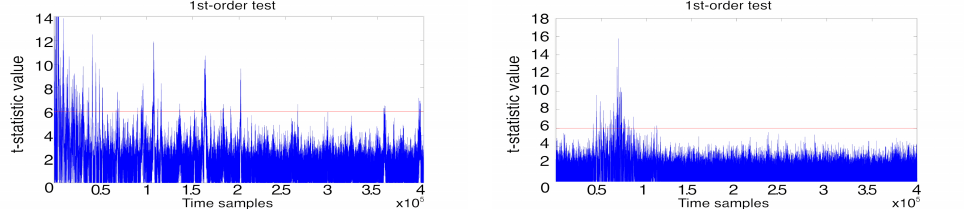
Figure 10: unprotected () random vs fixed input point